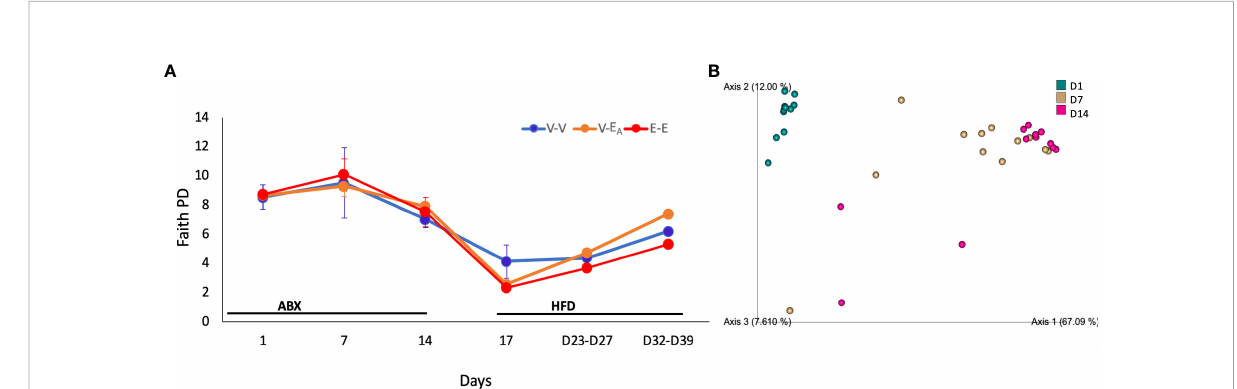
FIGURE 5 Antibiotics altered gut microbiota a -diversity and b -diversity in adult female mice. Mice received antibiotics in drinking water for two weeks. Starting on D15, mice received a total of 6 doses of FMT gavage with (V-E A ) or without A . muciniphila (E-E and V-V) supplementation. (A) Faith phylogenetic diversity (PD) (± SEM ) over time. Gut microbiota data from D23 and D27 (n = 8) were aggregated to isolate the effect during FMT, and D32 and D39 (n = 8), after the FMT was discontinued. (B) Principal component plot showing weighted Unifrac distance between microbiota communities during antibiotic treatment. E-E, E2-treated mice receiving FMT from E2 mice; V-V, mice with Veh implants receiving FMT from Veh mice; V-E A , mice with Veh implants receiving FMT from E2-treated mice, supplemented with A . muciniphila